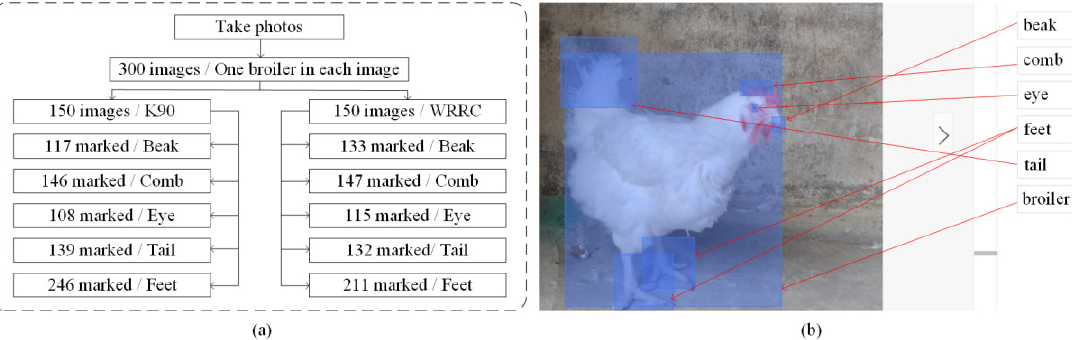
Figure 3. Datasets and marked examples: ( a ) Data partitioning; ( b ) Marked image as ground truth. The chicken dataset includes 300 images of broilers: 150 K90 broilers and 150 WRRC broilers. The K90 set contains 117 marked beaks, 146 marked combs, 108 marked eyes, 139 marked tails, and 246 marked feet. The WRRC set contains 133 marked beaks, 147 marked combs, 115 marked eyes, 132 marked tails, and 211 marked feet.